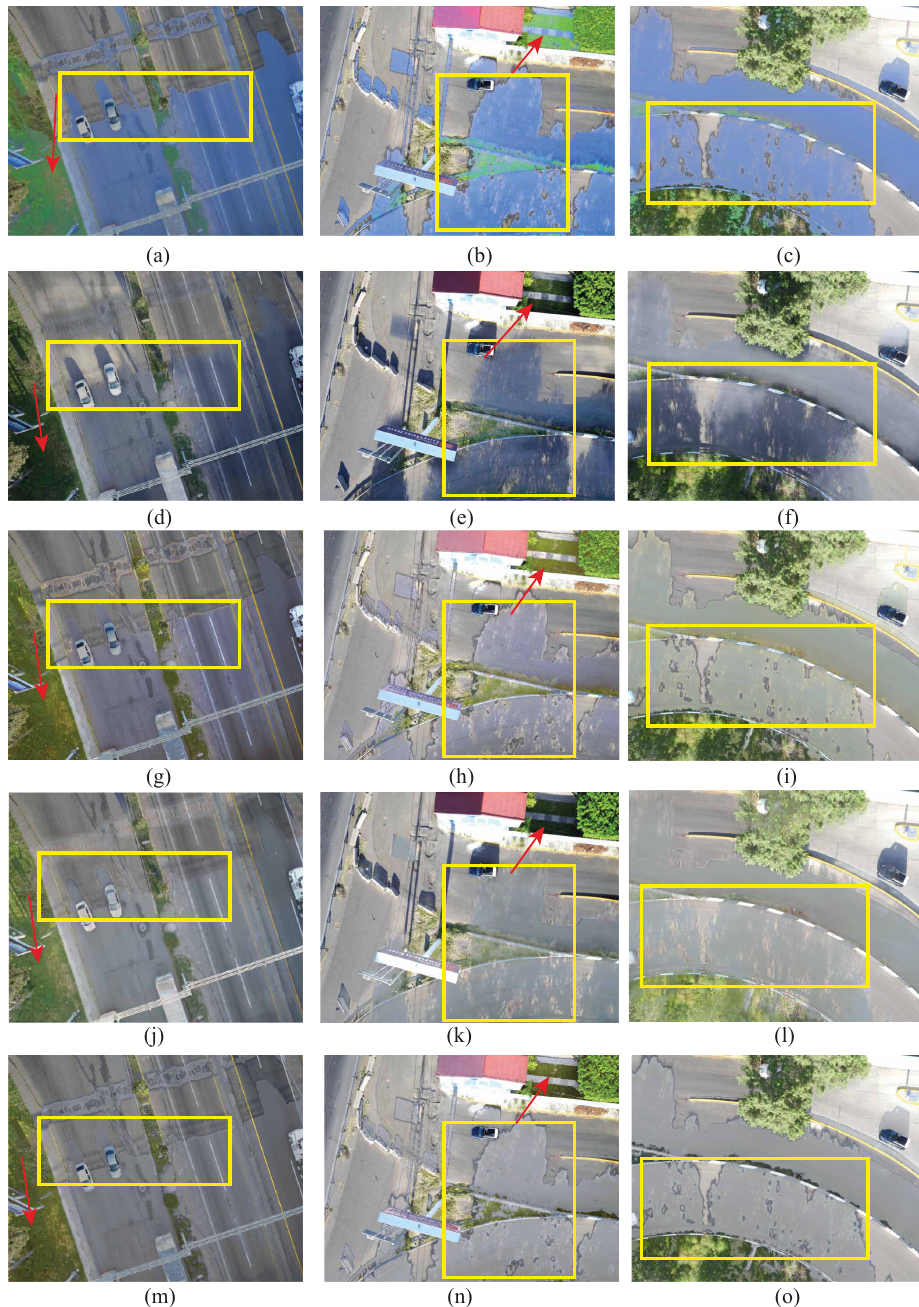
Figure 6. Illumination correction results for study cases 1 ( a ), 2 ( b ), and 3 ( c ); SMGAN method results for study cases 1 ( d ), 2 ( e ), and 3 ( f ); color transfer results for study cases 1 ( g ), 2 ( h ), and 3 ( i ); SynShadow method results for study cases 1 ( j ), 2 ( k ), and 3 ( l ); the roposed method results for study cases 1 ( m ), 2 ( n ), and 3 ( o